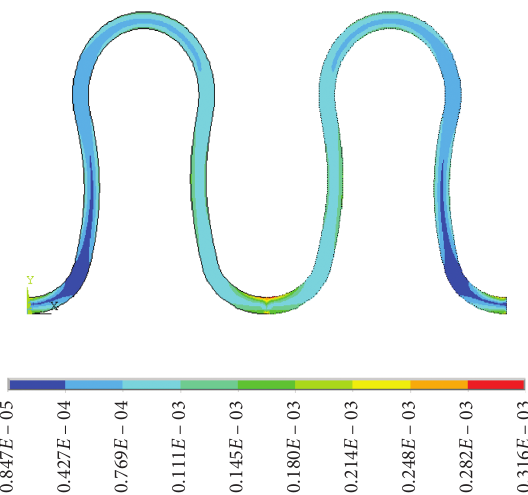
Figure 9: Stress distribution at air inlet and gas outlet side con- sidering thermal stress (Pa).